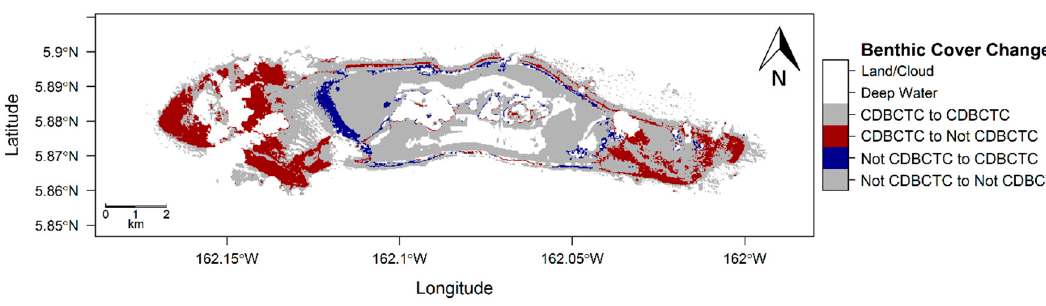
Figure 6. Difference in predicted class membership map for the Palmyra Atoll area of interest for 2001 initial state compared to 2015 final state.